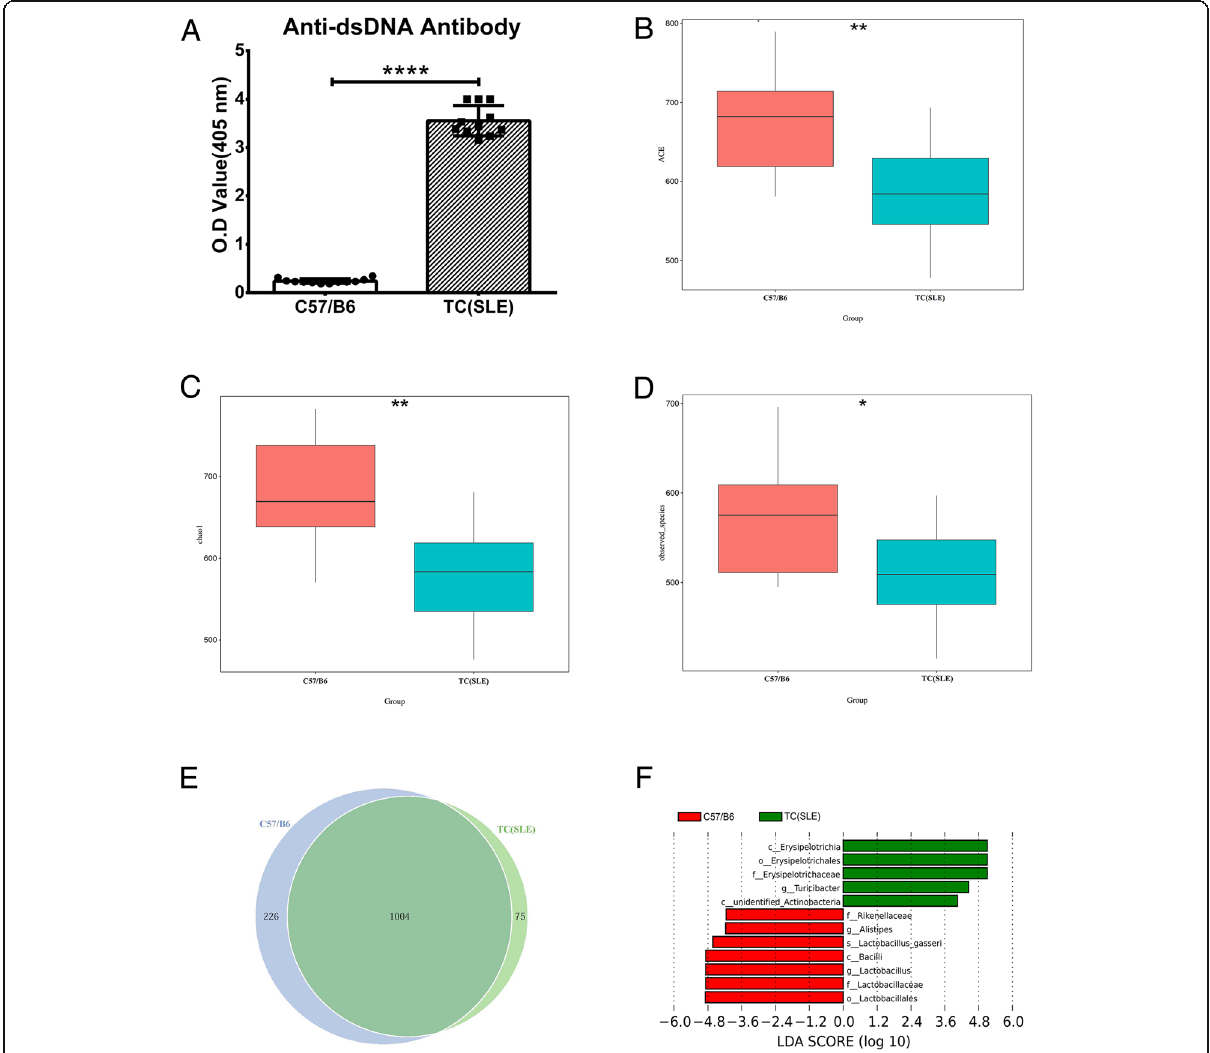
Fig. 1 Establishment of the diseased SLE model and analysis of gut microbiota in SLE mice and C57/B6 mice. (A) Anti-dsDNA antibody titers in TC (SLE) mice and C57/B6 mice (11 mice per group). (B-F) Feces of each group were collected for analysis of bacterial 16S DNA from the colorectum and determination of the (B) ACE index and (C) Chao1 index, * P < 0.05, ** P < 0.01. (D) Comparison of observed species comparison between groups. * P < 0.05. (E) Unique and shared microbiota of the two groups (Venn diagram). (F) LDA scores for different bacterial taxa of the two groups (p, phylum; c, class; o, order; f, family; g,